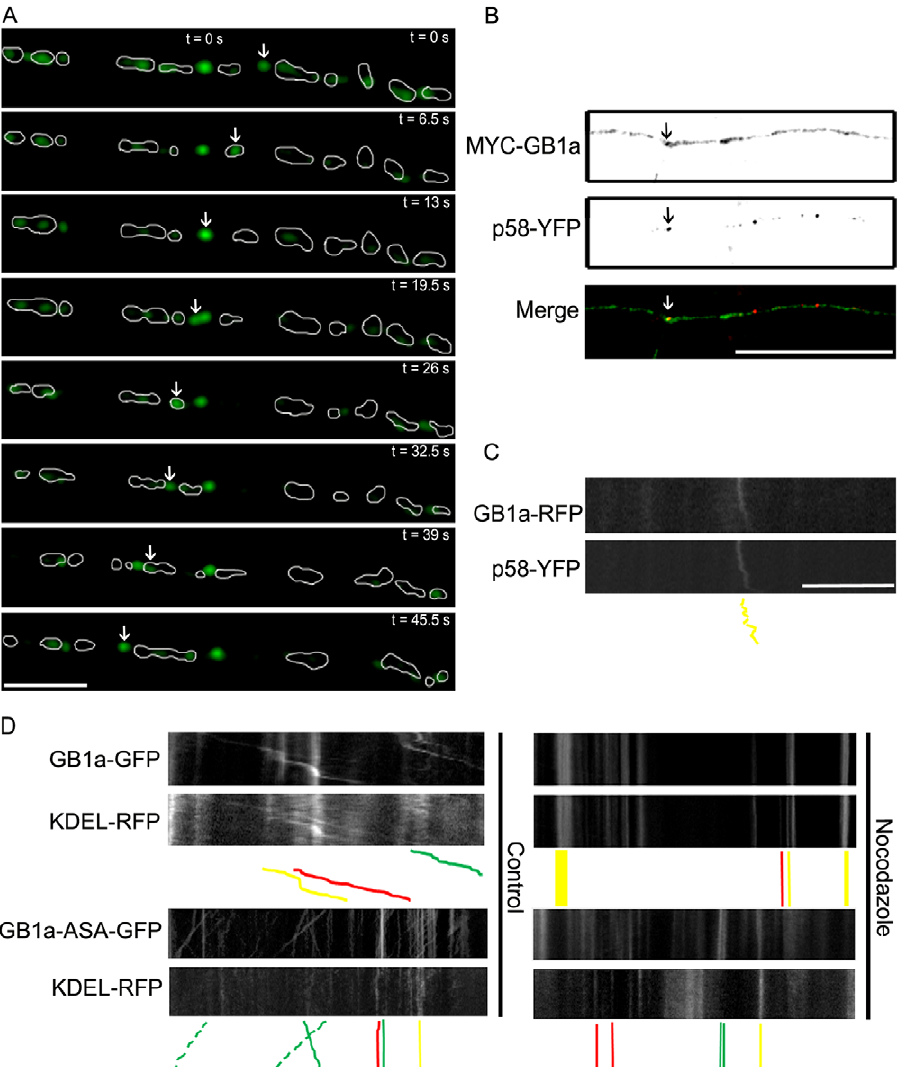
Figure 4. GABA B R1a cycles between KDEL compartments in axons. ( A ) Representative axon of hippocampal neurons transfected with GABA B R1a-EGFP and KDEL-RFP, and visualized live. The area originally occupied by the ER (KDEL-RFP) in each time frame was outlined in white. The arrows show a GABA B R1a-EGFP puncta that exits and enters different ER compartments within the observation period (45.5 s) (representative time- lapse sequence of n=10 neurons). Scale bar represents 20 m m. ( B ) Representative axon of hippocampal neurons transfected with MYC-GABA B R1a (MYC-GB1a) and p58-YFP, and processed for immunofluorescence under permeabilized conditions. MYC-GABA B R1a was detected with MYC antibodies (green); p58-YFP was visualized without staining (red). Merged images are shown on the bottom panel (representative image of n=23 neurons). Scale bar represents 20 m m. ( C ) Kymographs were constructed from time series of axons of hippocampal neurons transfected with GABA B R1a-RFP (GB1a-RFP) and p58-YFP. Solid yellow lines: synchronous transport of GABA B R1a-RFP and p58-YFP (representative kymograph of n=22 neurons). Scale bar for C-D represents 20 m m. ( D ) Kymographs were constructed from time series of axons of hippocampal neurons under control conditions or treated with nocodazole after transfection with GABA B R1a-EGFP (GB1a-GFP) or GABA B R1a-ASA-EGFP (GB1a-ASA-GFP) and KDEL- RFP. Top right panels: accumulated GABA B R1a-EGFP and KDEL-RFP in static puncta (solid yellow lines). Bottom right panels: accumulated GABA B R1a- ASA-EGFP and KDEL-RFP in different static puncta (solid green and red lines) (representative kymograph of n=21 neurons).